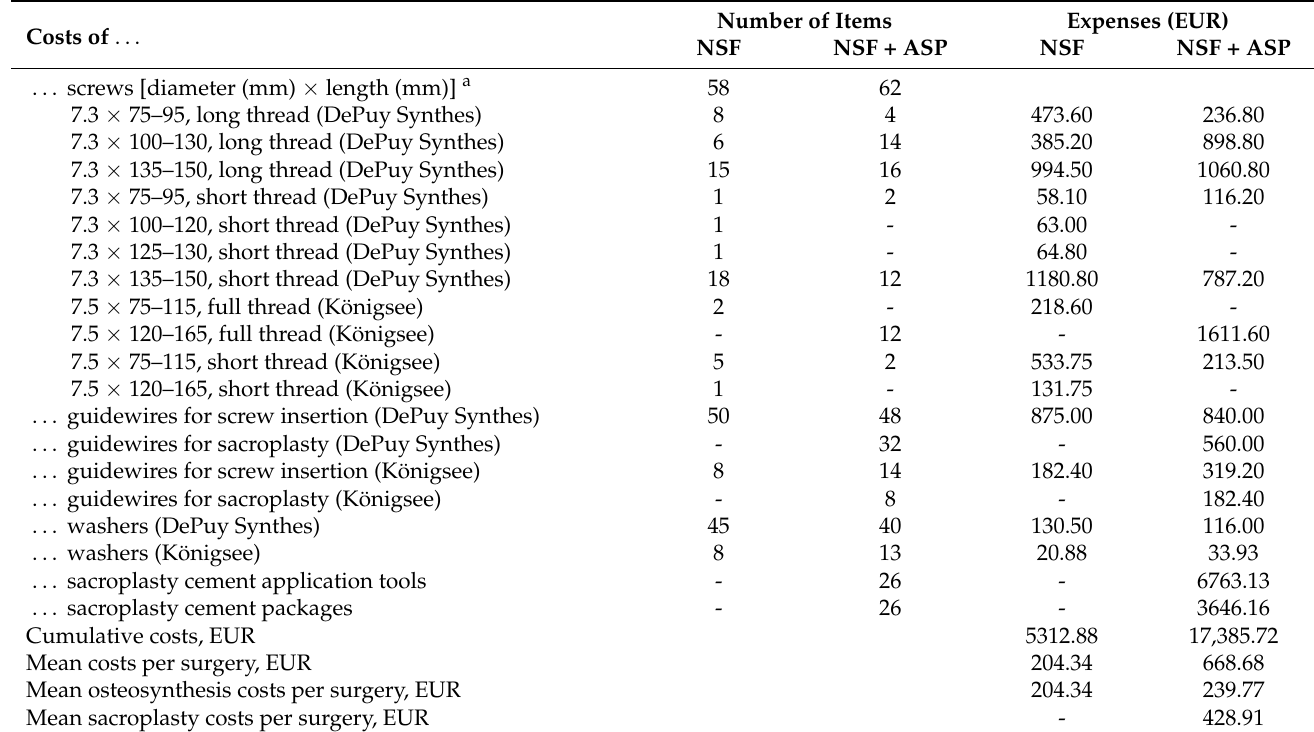
Table 3. Procedural costs regarding screws inserted (depending on screw dimensions), and sacroplas- ties performed.